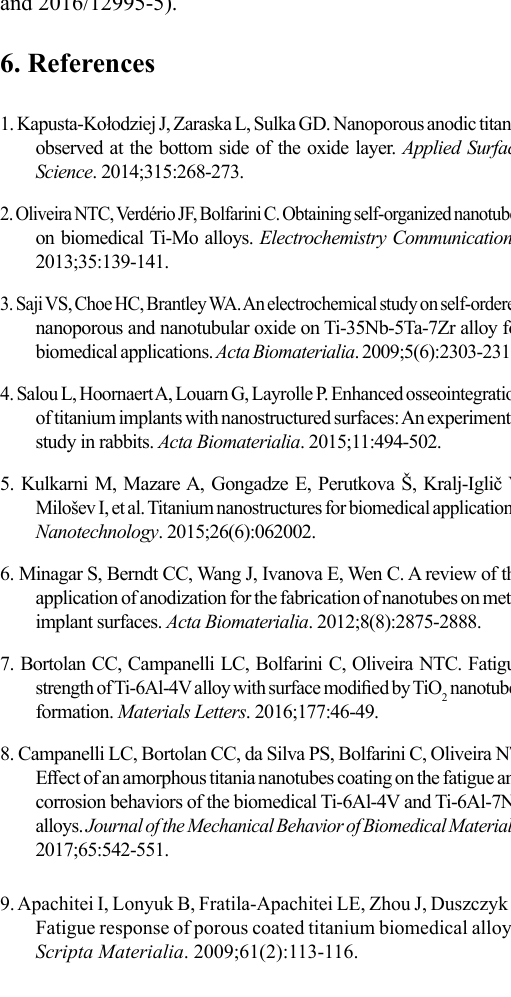
fatigue response. In the present work, the crystallization of the oxide may have changed the deformation behavior since cracks were detected after the fatigue tests. As presented in Figure 6, several cracks can be observed in both specimens treated at 450 and